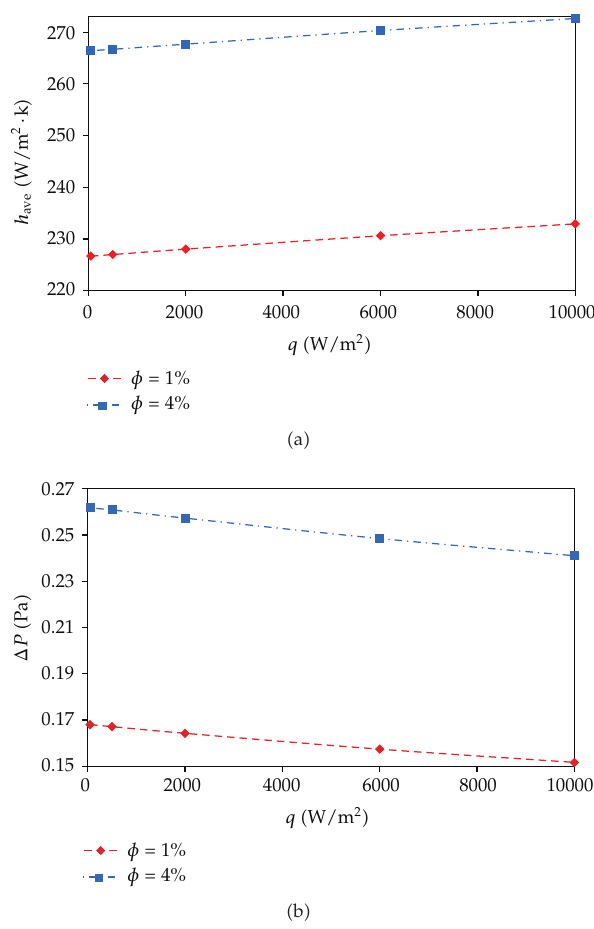
Figure 12: E ff ect of parameters φ and q on (cid:3) a (cid:5) averaged heat transfer coe ffi cient and (cid:3) b (cid:5) pressure drop. (cid:3) Re (cid:4) 100 (cid:5)